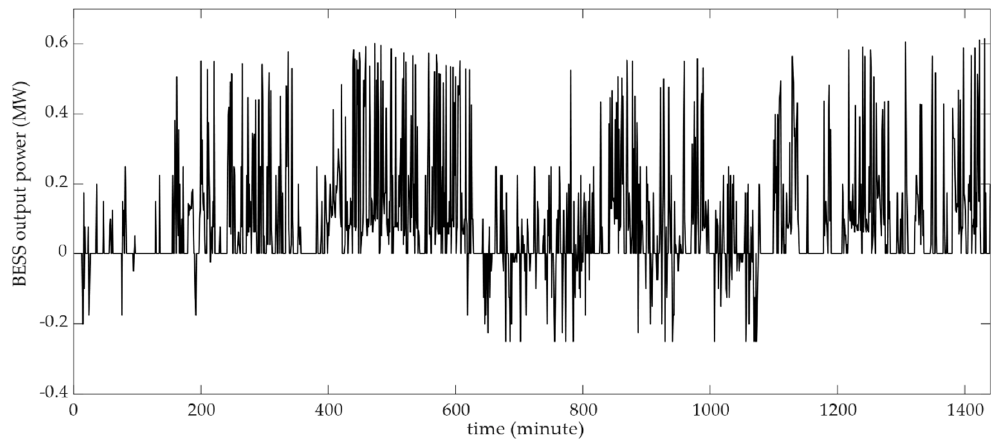
Figure 12. Battery storage power output without DoF strategies. P is given by Equation (2).